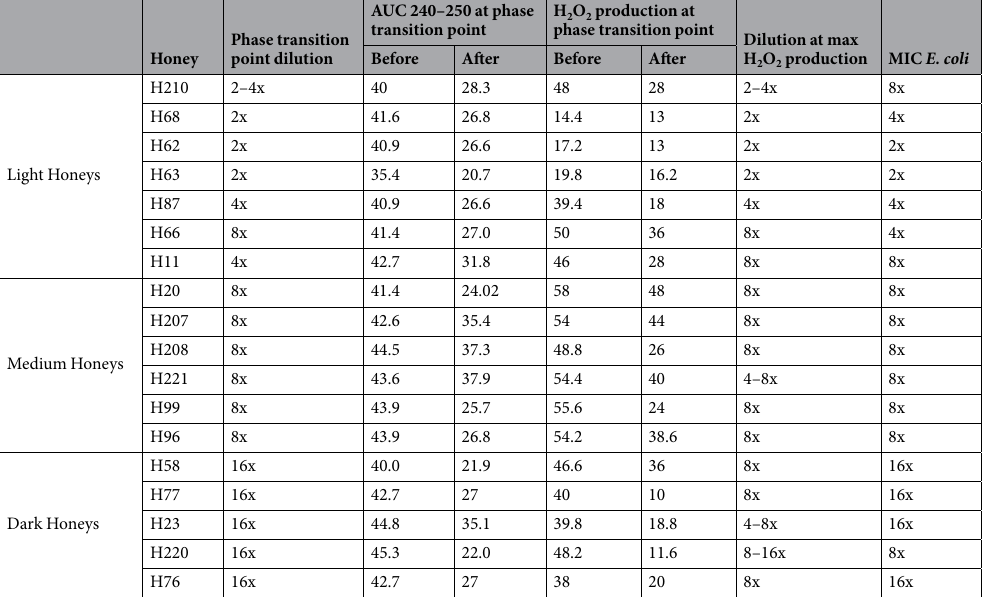
Table 5. Summary of the relationship between the dilution at phase transition point, H 2 O 2 production and MIC against E. coli